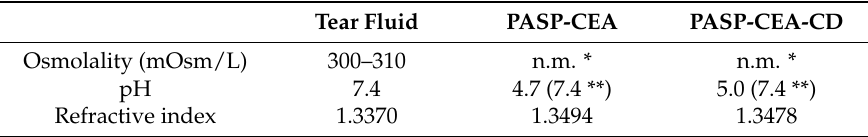
Table 1. Measured values of osmolality, pH and refractive